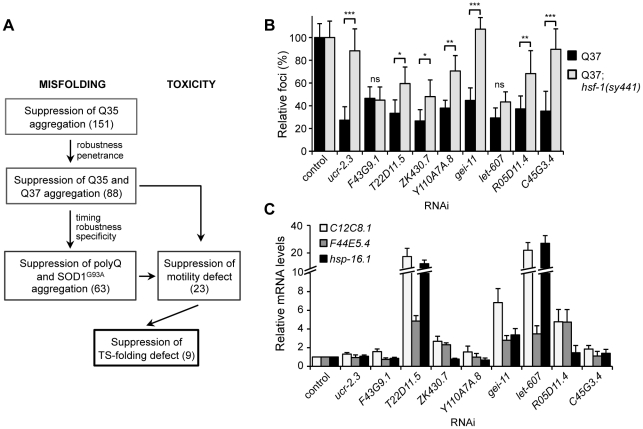
Core PN modifiers and activation of the heat shock response.(A) Screening strategy to identify genetic modifiers that enhance the folding environment and are effective in multiple misfolding models. (B) Suppression of polyQ aggregation by the final nine modifiers dependence on HSF-1. Aggregate quantification on RNAi-treated Q37;hsf-1(sy441) hypomorphic mutant animals relative to control (±SD). Student t-test *p<0.05; **p<0.01; ***p<0.001 (ns, non-significant). (C) Real-time qPCR analysis of the levels of hsp (C12C8.1, F44E5.4, hsp-16.1) genes in RNAi-treated wt animals. Data are relative to the levels of each gene in wt;EV control (±SD) from 3 biological replicates.